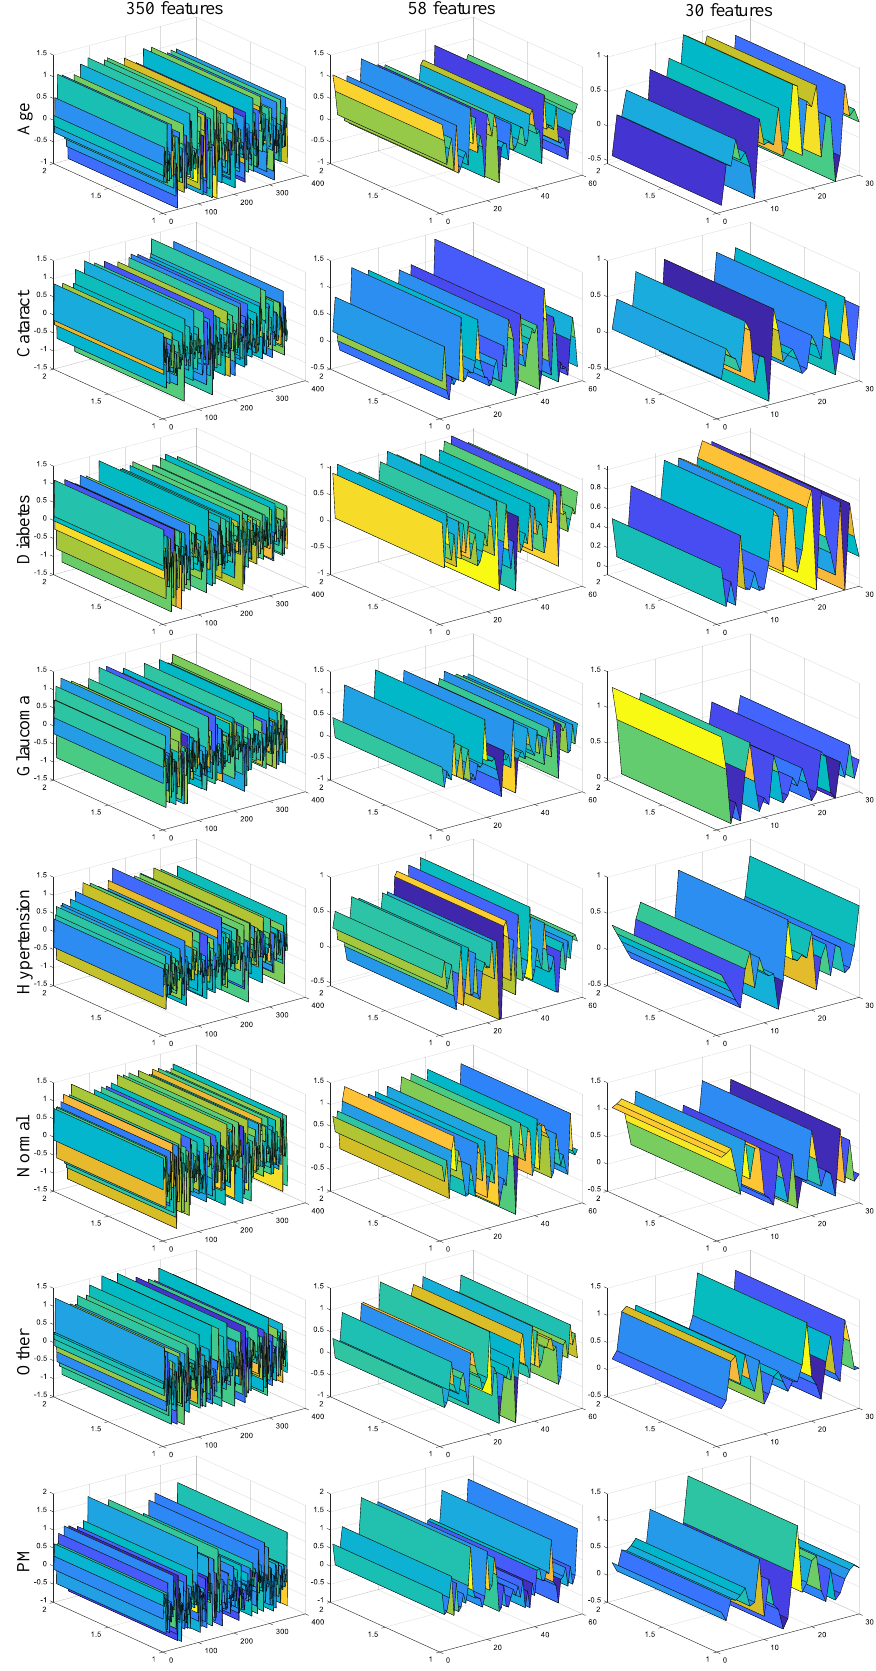
Figure 8. 3D representations of deep features for feature selection situations.